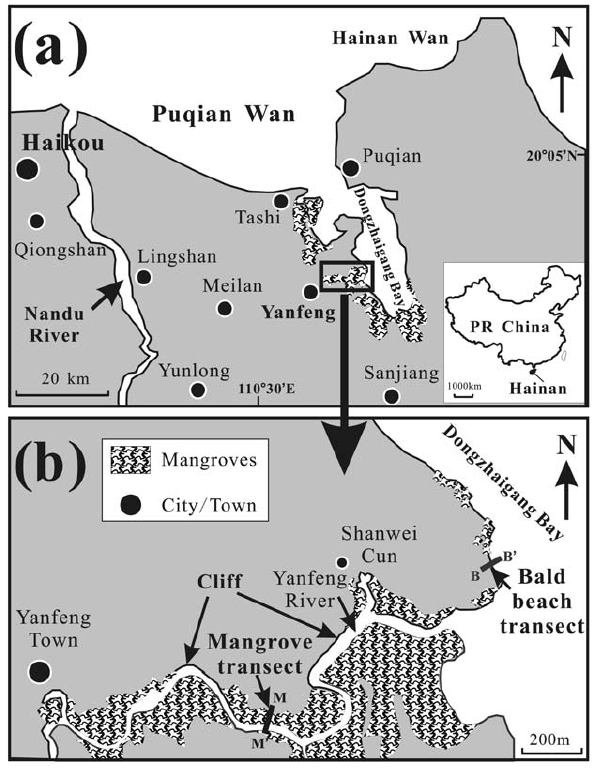
Fig. 1. Location maps of (a) Dongzhaigang National Nature Reserve (DNNR), China and (b) the mangrove transect M-M ′ and the bald beach transect B-B ′ .